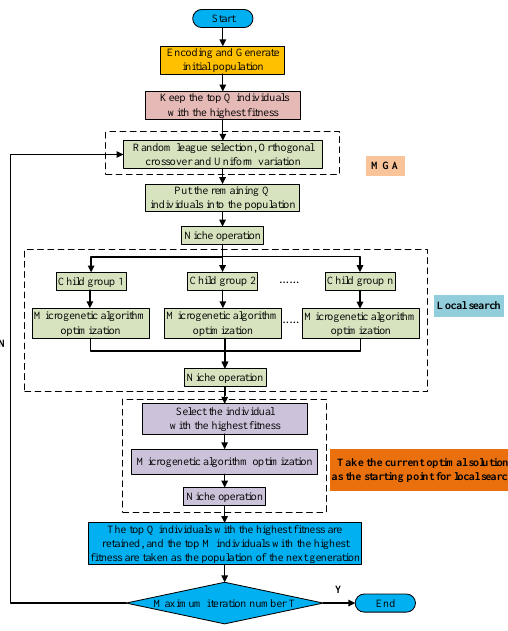
Figure 2. Flowchart of HNOGA